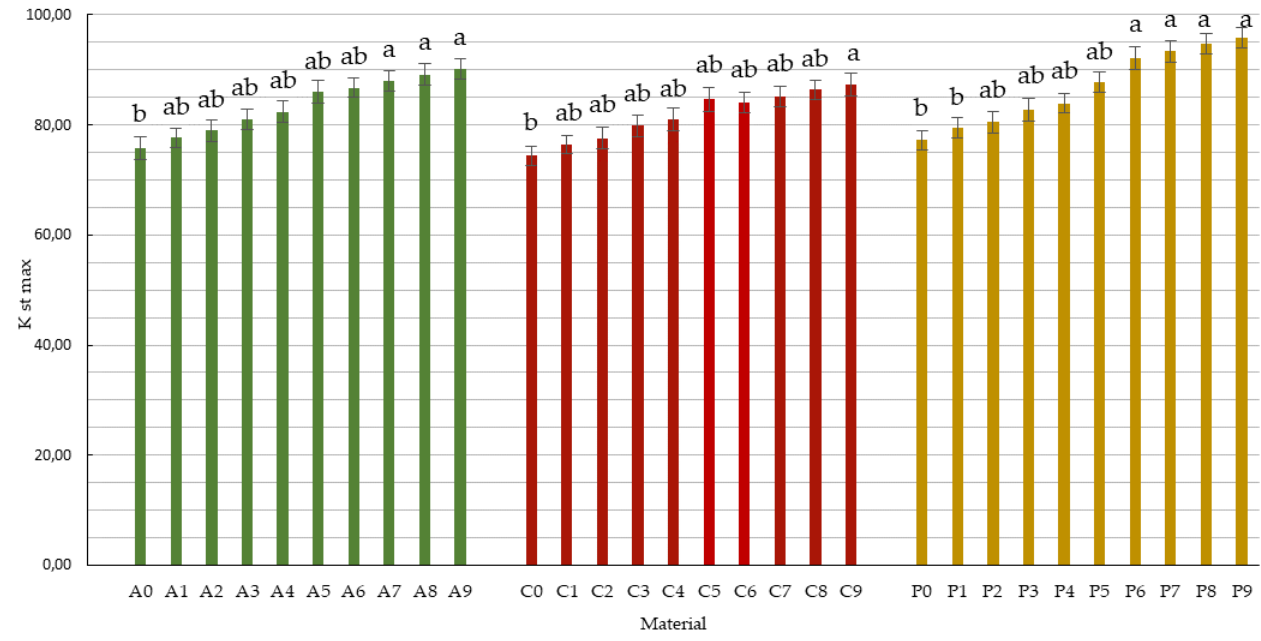
Figure 2. Changes in dust explosivity rates in samples of apple, cherry, and pear branches and in the biochars produced. Differences between average values marked with the same Arabic letters (a–b) are not statistically significant at the level of p ≤ 0.05 according to the Duncan test.